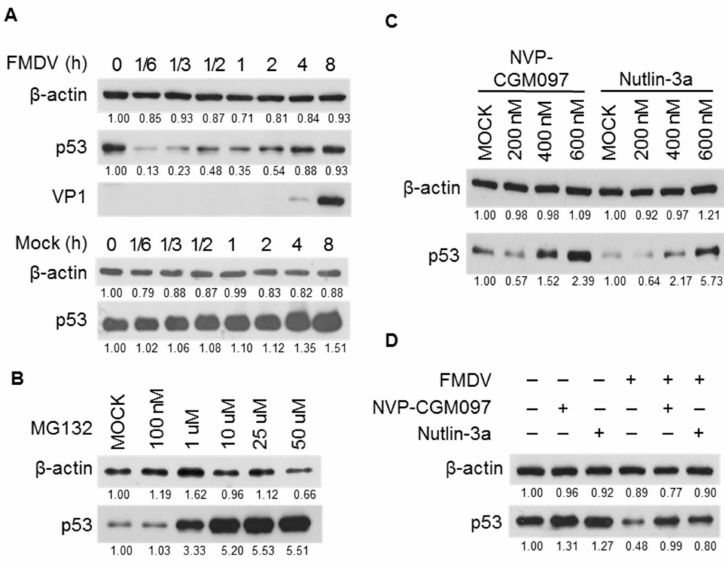
Figure 1. p53 protein level was dynamically regulated during foot-and-mouth disease virus (FMDV) infection partly through MDM2-dependent proteasome pathway. ( A ) p53 level was dynamically regulated during FMDV infection. BHK-21 cells, seeded in 60-mm dishes, were either mock-treated or infected with FMDV (multiplicity of infection (MOI) = 0.1) and harvested at the time points indicated. Western blotting (WB) was performed to detect p53 and VP1. ( B ) MG132 treatment increased the protein abundance of p53. BHK-21 cells were seeded in 6-well plates and were respectively treated with MG132 at a gradient concentration from 100 nM to 50 µ M for 2 h. Samples were collected and then WB was performed to detect p53 expression. ( C ) Treatment with MDM2-specific inhibitor increased the p53 protein level. BHK-21 cells were plated in 60-mm dishes and then treated with MDM2 inhibitor NVP-CGM097 and Nutlin-3a at di ff erent concentrations (200 nM to 600 nM) for 12 h, and then the expression level of p53 was measured by WB. ( D ) Pre-treatment with MDM2 inhibitor compromised the reductive e ff ect of FMDV infection on p53. BHK-21 cells were respectively pre-treated with 600 nM of the MDM2 inhibitor NVP-CGM097 and Nutlin-3a for 12 h. After that, cells were then either mock-treated or infected with FMDV (MOI = 0.1) for 30 min. Samples were harvested for WB to detect p53. The bands were quantified with ImageJ software and the relative expression value was given just below the corresponding band. All the experiments were repeated at least twice and similar results were obtained. β -actin was used as the internal